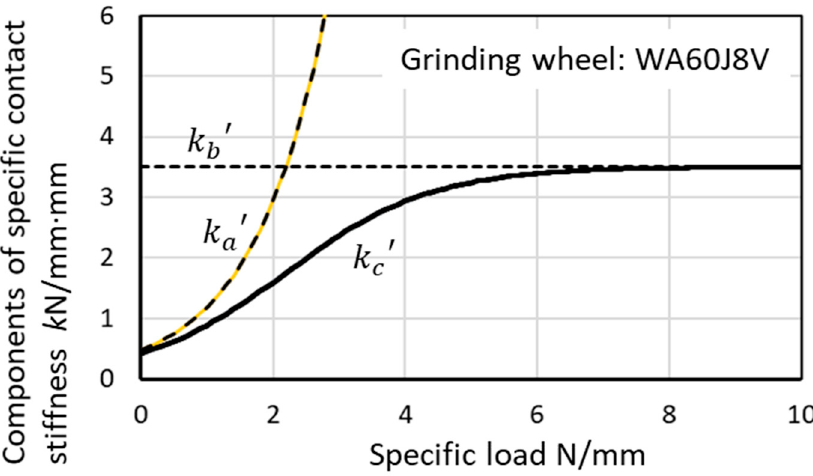
Figure 16. Components of specific contact stiffness.